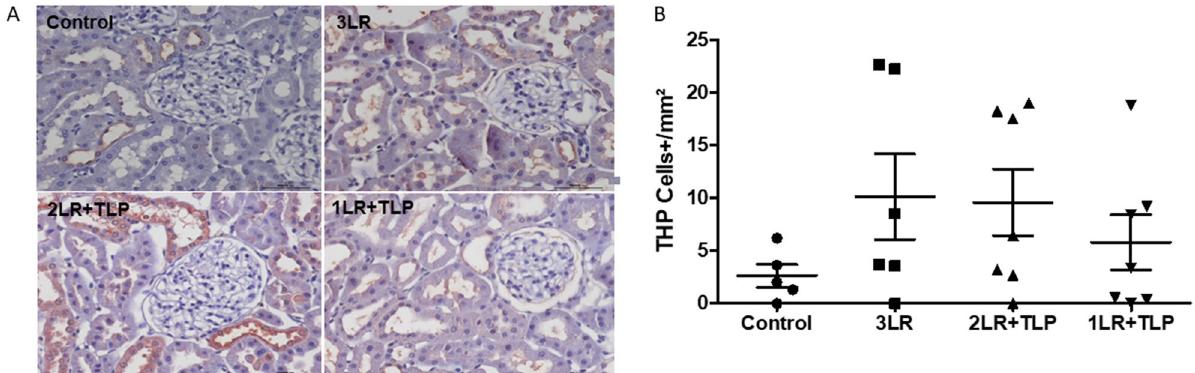
Figure 8. Immunohistochemical analysis of uromodulin expression in rat kidney tissue. Immunostaining [brown, in ( A )] for uromodulin+ cells in kidney cortex samples from control, 3LR, 2LR + TLP, and 1LR + TLP group rats. Magnification, × 400. ( B ) Bar graph of uromodulin expression. Control, no intervention; 3LR, induction of hemorrhagic shock, followed by infusion of lactated Ringer’s at 3 times the volume of the blood withdrawn; 2LR + TLP, induction of hemorrhagic shock, followed by infusion of lactated Ringer’s at 2 times the volume of the blood withdrawn, together with intravenous injection of terlipressin at 10 µg/100 g body weight; 1LR + TLP, induction of hemorrhagic shock, followed by infusion of lactated Ringer’s at a volume equal to that of the blood withdrawn, together with intravenous injection of terlipressin at 10 µg/100 g body weight.